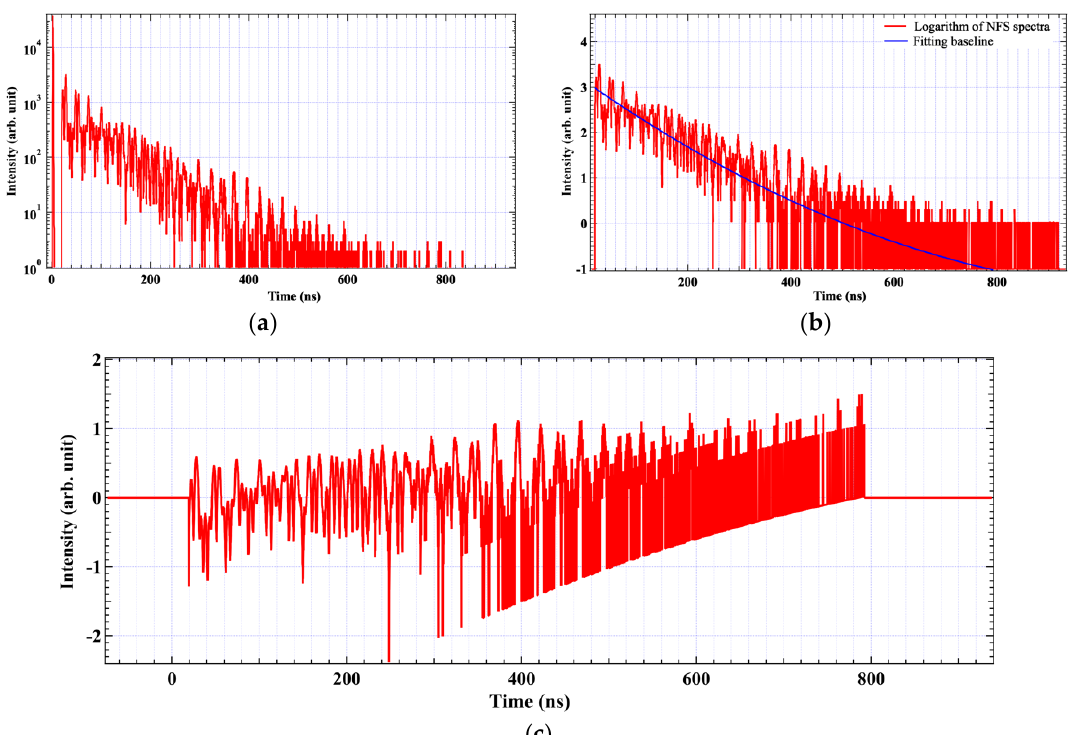
Figure 3. ( a ) the NFS spectrum of hematite at room temperature; ( b ) the red line represents the logarithm of NFS spectra and the blue line represents the fitting baseline by polynomial function; ( c ) the fringes of quantum beats after isolating the baseline.